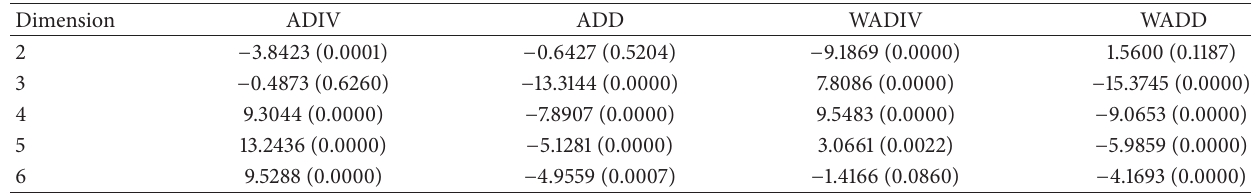
Table 3: BDS tests for nonlinearity.